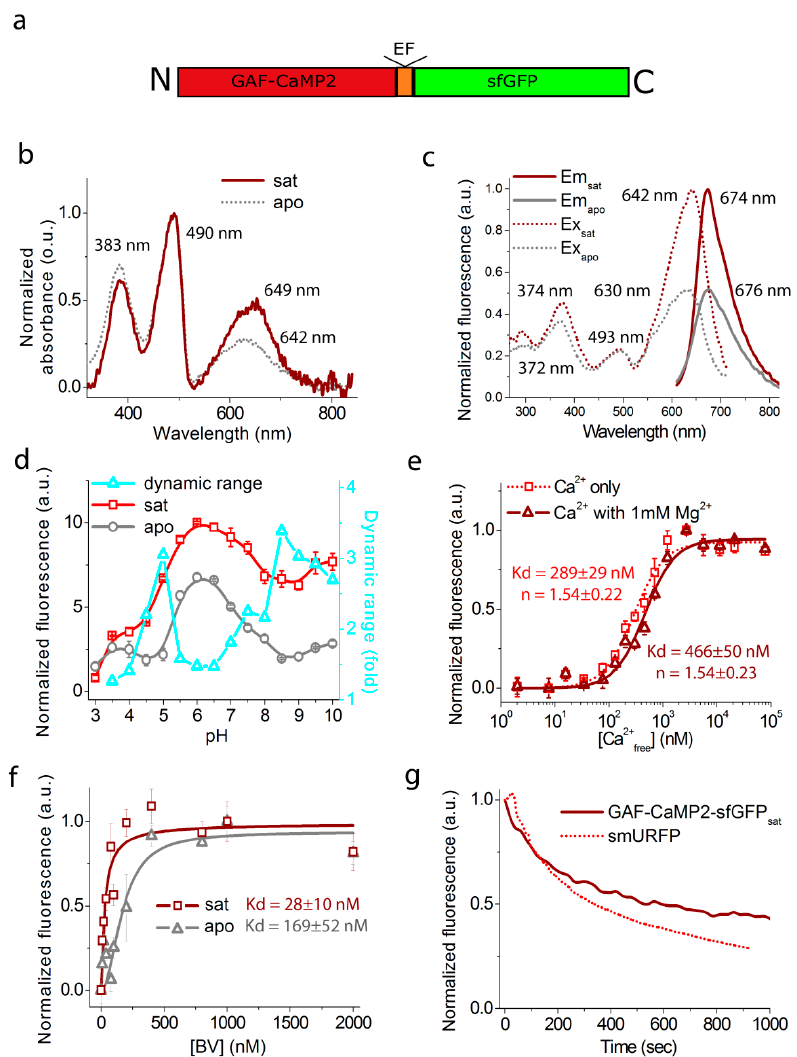
Figure 4. In vitro properties of the purified ratiometric GAF-CaMP2-sfGFP indicator. ( a ) A scheme for the fusion of GAF-CaMP2 indicator and sfGFP. ( b ) Absorbance spectra for GAF-CaMP2-sfGFP in Ca 2+ -bound and Ca 2+ -free states at pH 7.2. ( c ) Excitation and emission spectra for GAF-CaMP2-sfGFP in Ca 2+ -bound and Ca 2+ -free states, pH 7.2. ( d ) Fluorescence intensity for GAF-CaMP2 in its fusion with sfGFP in Ca 2+ -bound and Ca 2+ -free states as a function of pH. Three replicates were averaged for analysis. Error bars represent the standard deviation. ( e ) Ca 2+ titration curves for GAF-CaMP2 in fusion with sfGFP in the absence and in the presence of 1 mM MgCl 2 , pH 7.2. Three replicates were averaged for analysis. Error bars represent the standard deviation. ( f ) BV titration of the GAF-CaMP2-sfGFP in Ca 2+ -bound and Ca 2+ -free states at pH 7.2. The experimental data were fitted by Hill equation. ( g ) Photobleaching curves for GAF-CaMP2 in its fusion with sfGFP in Ca 2+ -bound state and smURFP. The power of light before objective lens was 2.23 mW/cm 2 . Four replicates were averaged for analysis.